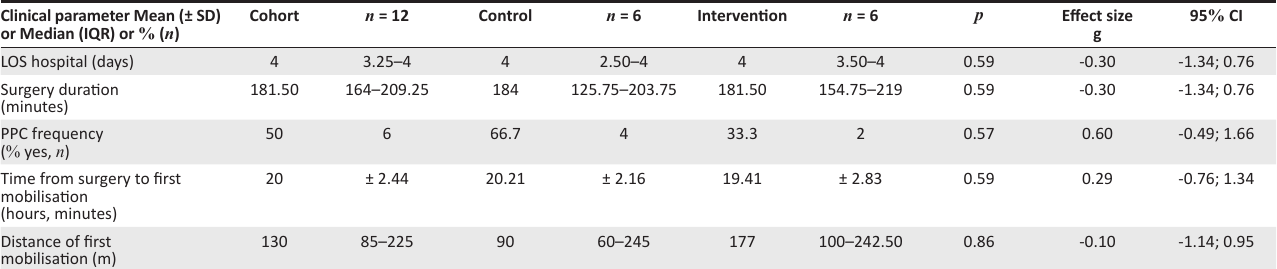
TABLE 2: Comparison of clinical parameters ( n =